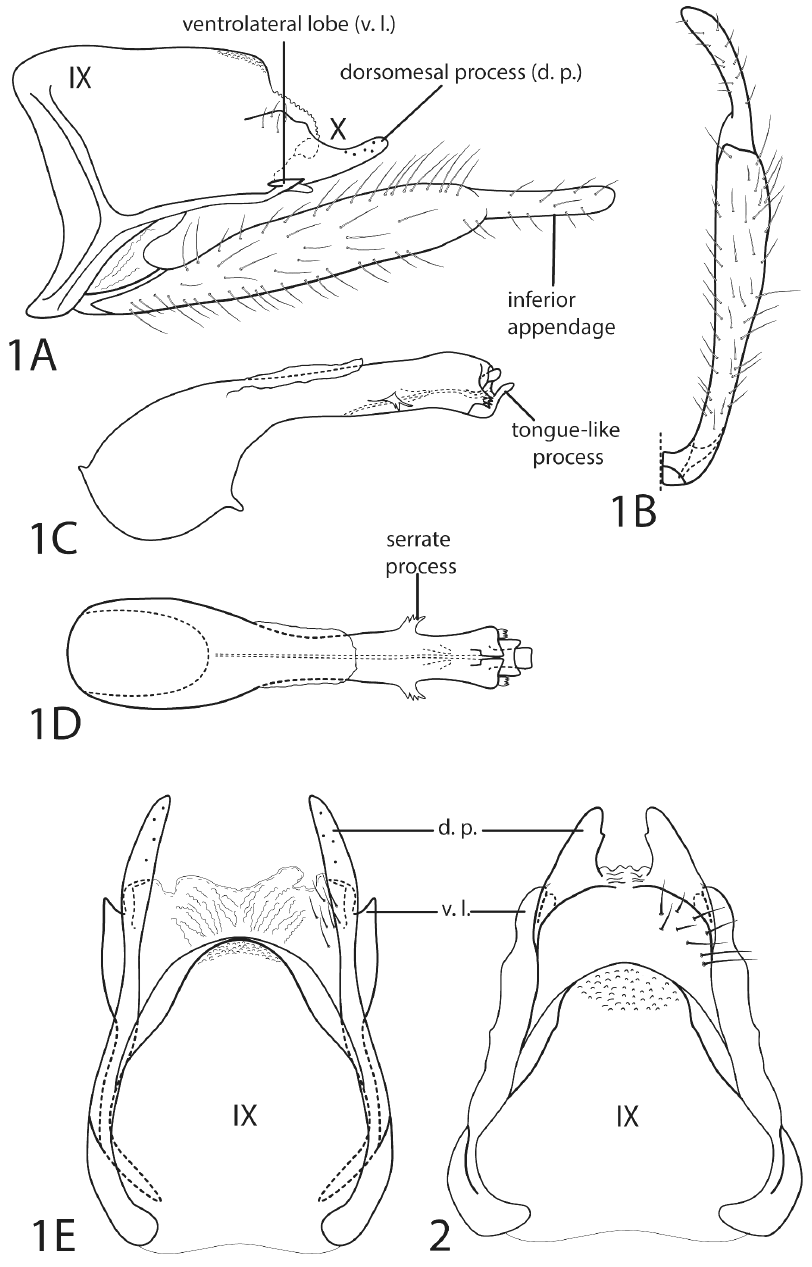
Figure 1–2. Smicridea ( R. ) lobata (Ulmer, 1909) and Smicridea ( R. ) signata Banks, 1903, male genitalia. 1A Smicridea ( R. ) lobata segments IX and X, lateral 1B Left inferior appendage, ventral 1C Phallus, lateral 1D Phallus, dorsal 1E Segments IX and X, dorsal 2 Smicridea ( R. ) signata . Segments IX and X, dorsal. These illustrations were made from specimens of S. lobata from Zulia and Sucre States, Venezuela, and specimens of S. signata from Utah,